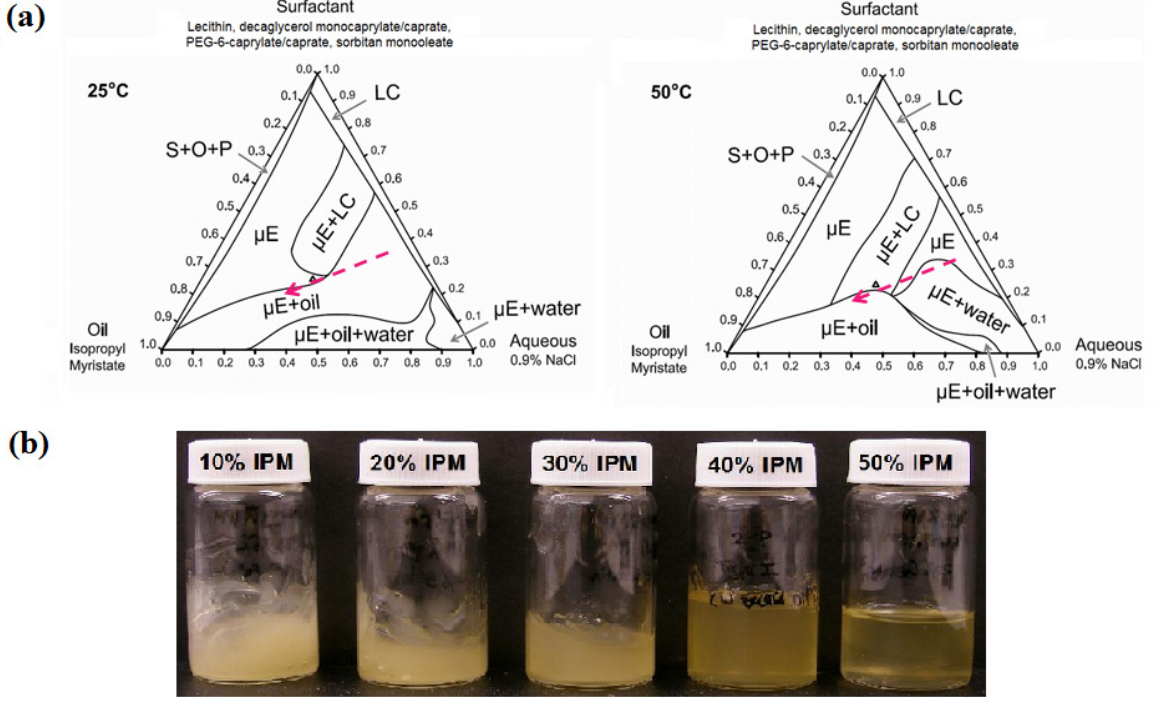
Figure 6. ( a ) Oil dilution path (dashed arrow) used to produce MBGs with 10% to 50% IPM; ( b ) Appearance of MBGs at room temperature. Ternary phase diagrams at 25 °C and 50 °C. The surfactant vertex is a mixture of 1:2:0.8:1.2 weight ratio of lecithin: PEG-6-caprylic/capric glycerides:decaglycerol